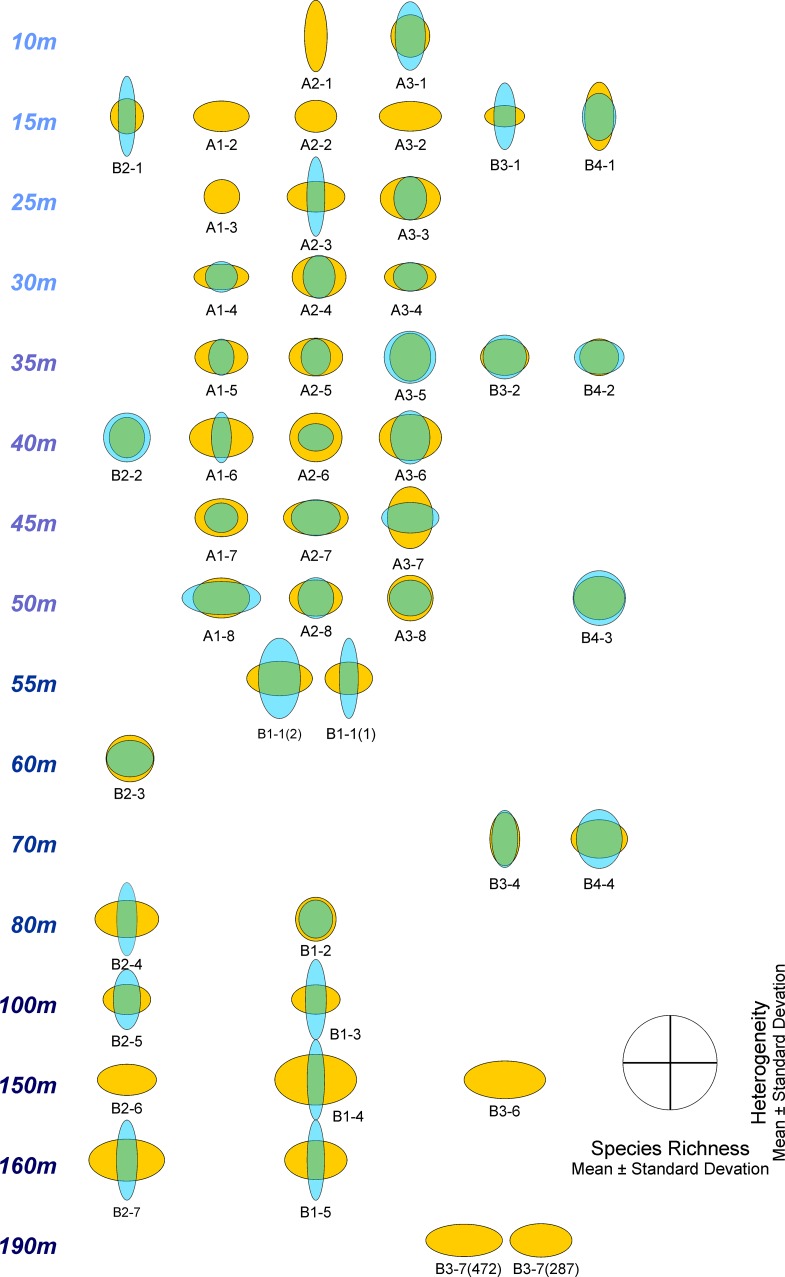
Diversity diagrams of sample sites in Fig 8 arranged by transects and water depth.Living assemblages in light blue and dead assemblages in orange.